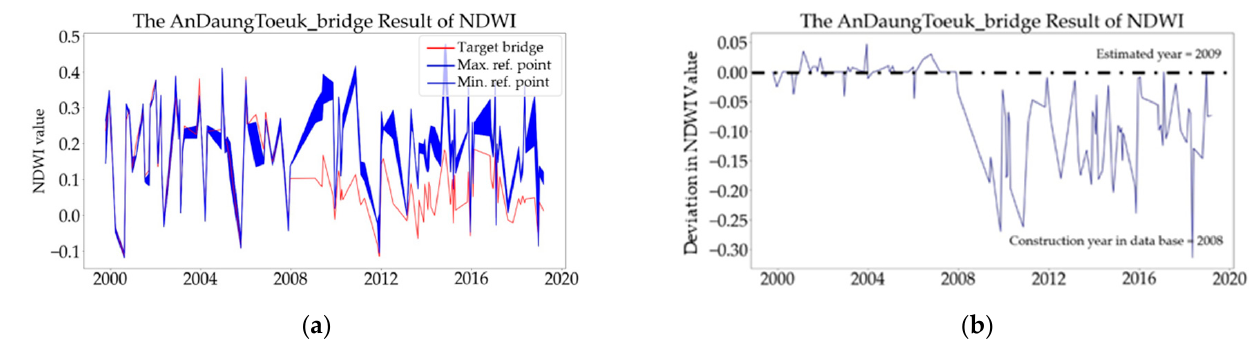
Figure 9. ( a ) Variation in NDWI index value of the target bridge (point) and the reference points for the An Daung Bridge; ( b ) re-visualization of ( a ) showing difference between NDWI value of target and that of the closest reference point.